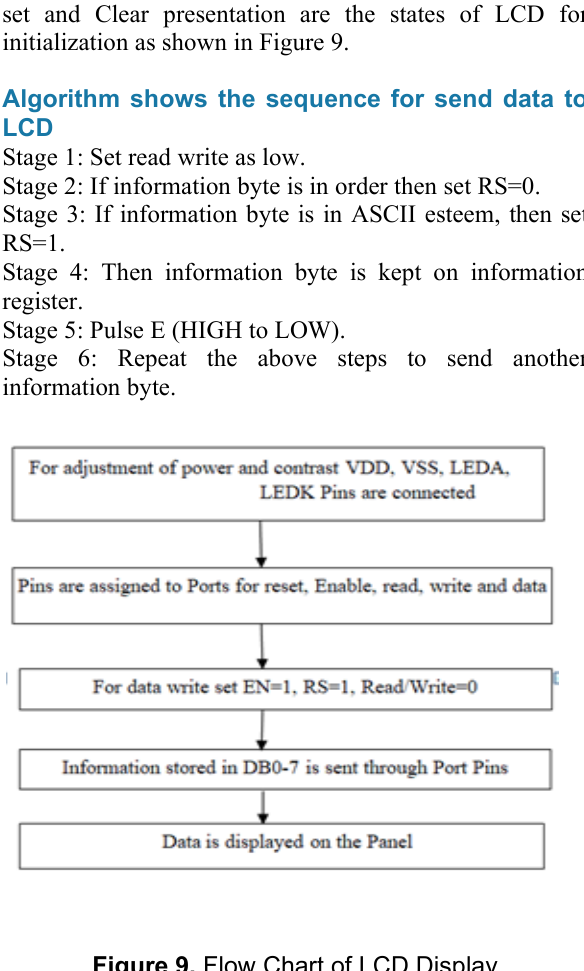
Fi gure 9. Flow Chart of LCD Display